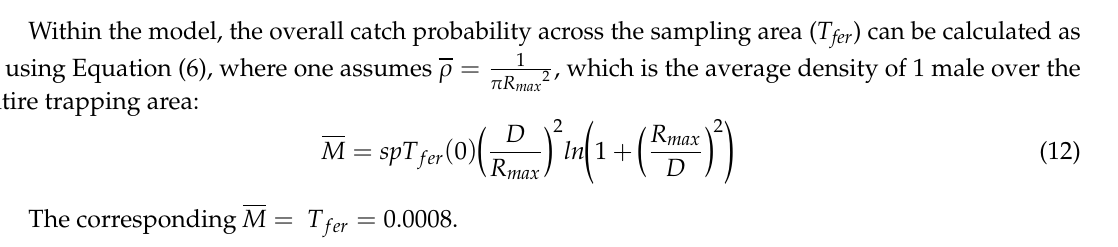
Figure 7. Experimental validation of the new model. Dots: experimental proportion of males caught in pheromone-baited traps placed at various distances from the release point ( shown when smaller than the symbol size. Solid line: the model described by Equation